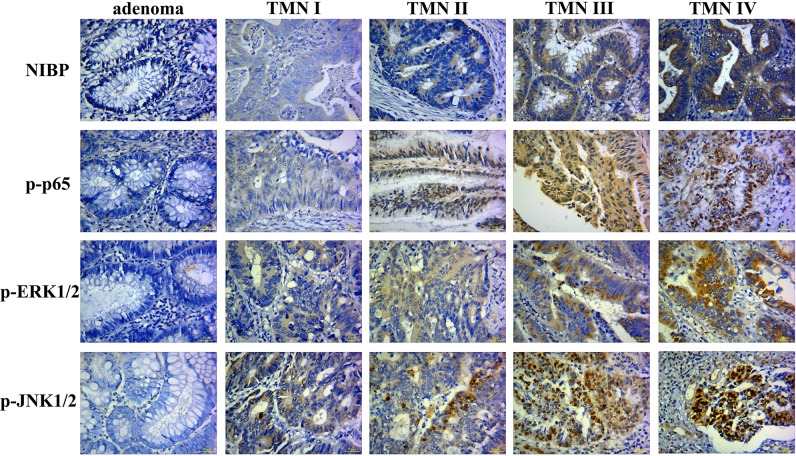
Immunohistochemical analysis of NIBP, p-p65, p-ERK1/2, and p-JNK1/2 expression in colorectal adenomas and adenocarcinomas.NIBP, p-p65, p-ERK1/2, and p-JNK1/2 protein expression was higher in late CRC stages (TNM III and TNM IV) compared to early CRC stages (TNM I and TNM II) or adenomas. In addition, NIBP, p-p65, p-ERK1/2, and p-JNK1/2 expression was higher in mucinous adenocarcinomas and tubular adenocarcinomas compared to adenomas.